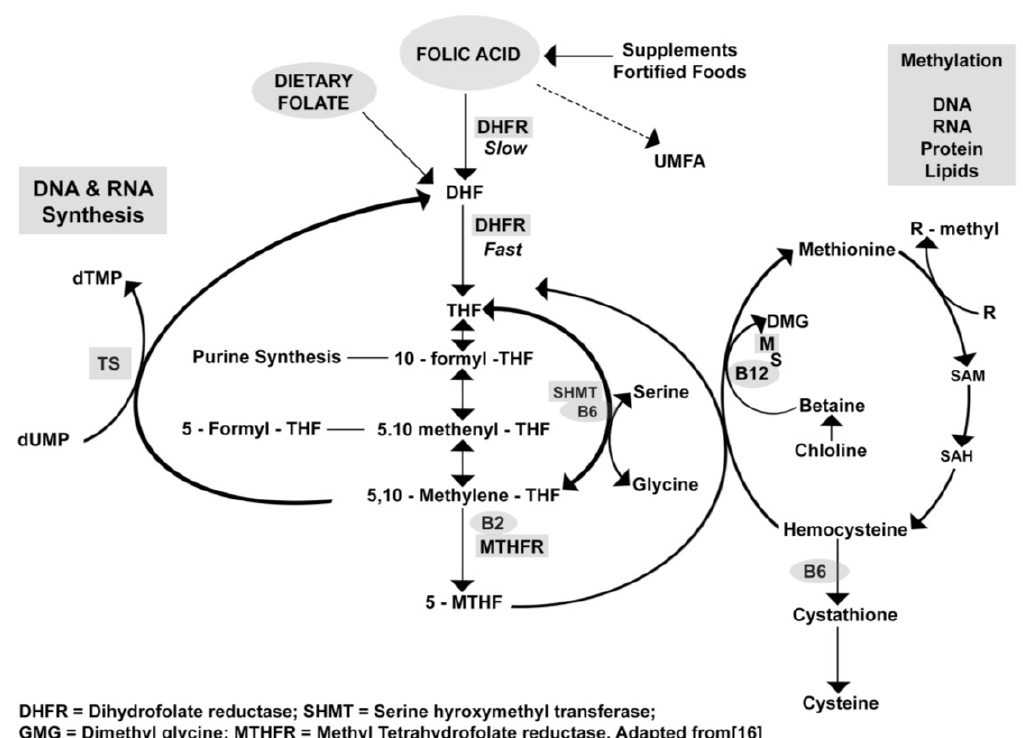
Figure 1. Folate metabolism